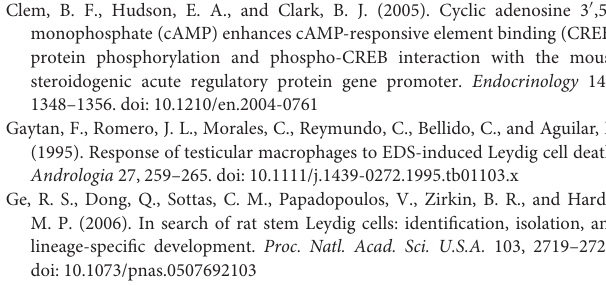
Figure S1 | PTHrP does not stimulate EdU incorporation into stem Leydig cells in vitro . Seminiferous tubules were incubated with increasing concentration of PTHrP (0, 10, 100, and 1,000 pg/mL) for 5 days. (A) the control; (B) 1,000pg/mL PTHrP; EdU labeled cell shows green staining in the nucleus (White arrow). (C) Seminiferous tubules were incubated with increasing concentration of PTHrP (0, 10, 100, and 1,000pg/mL) for 7 days and then the tubules were switched into the medium containing ITS + LH + LI for 14 days being induced into the Leydig cells to produce testosterone. Mean ± SEM, n = 6. No significance was found in the testosterone levels between each PTHrP group and control